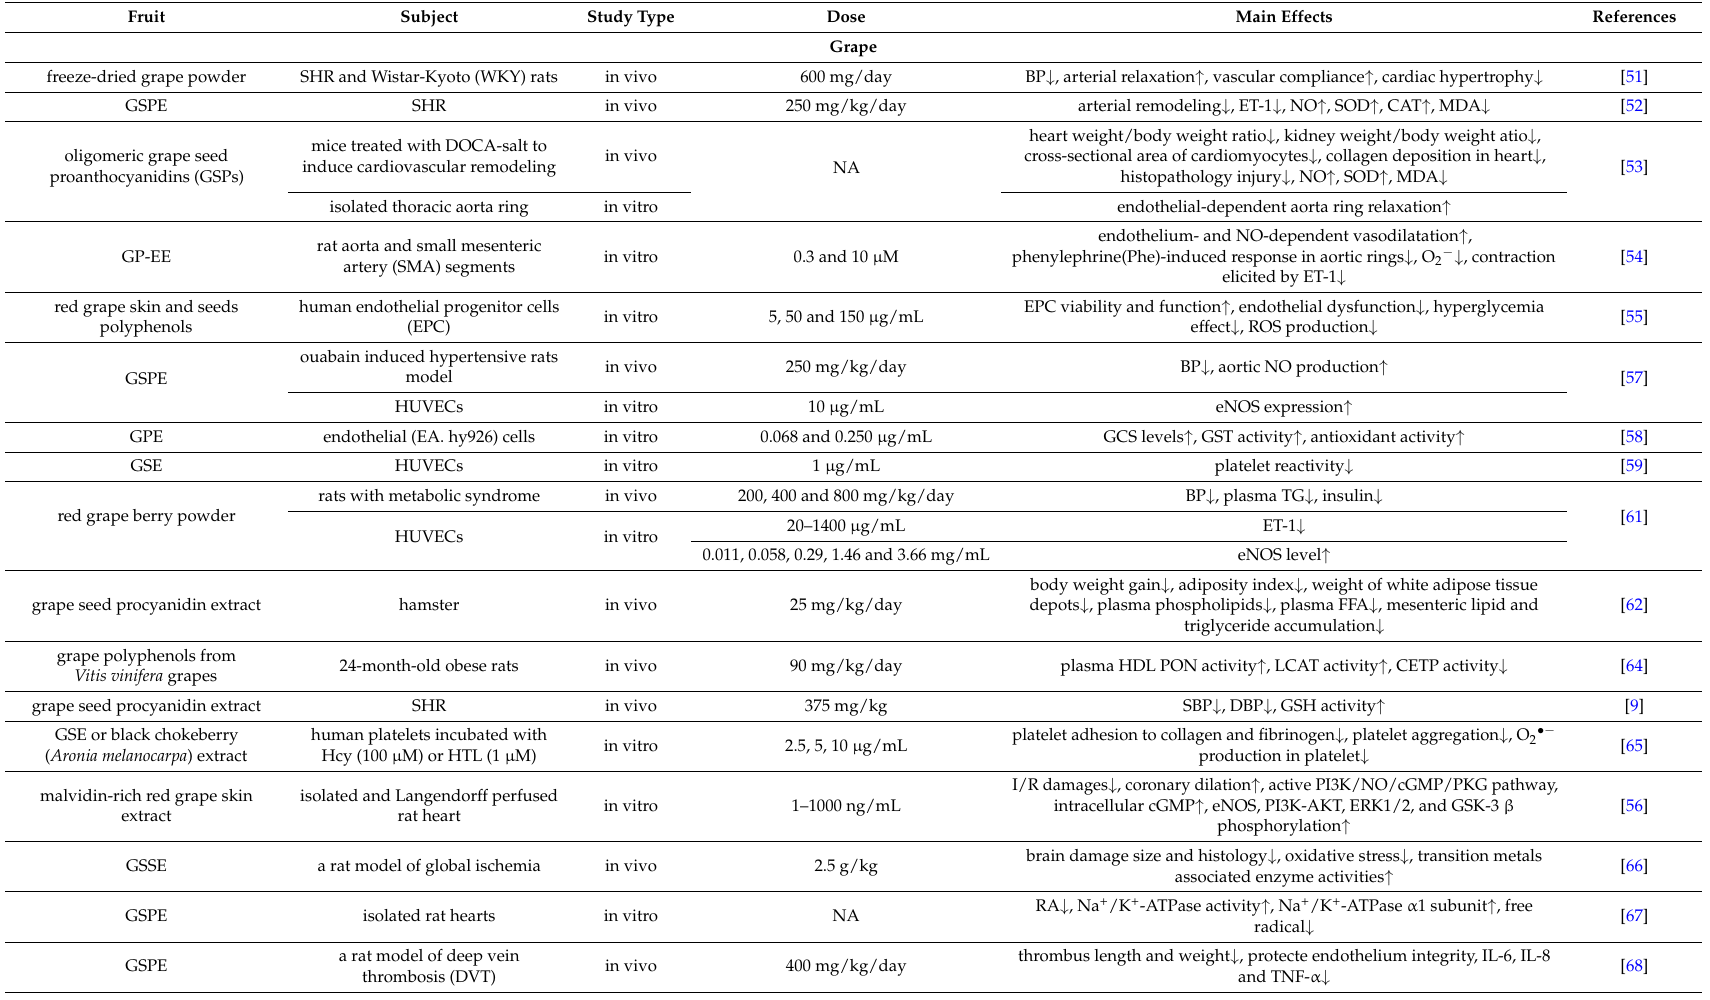
Table 2. The cardioprotective abilities of